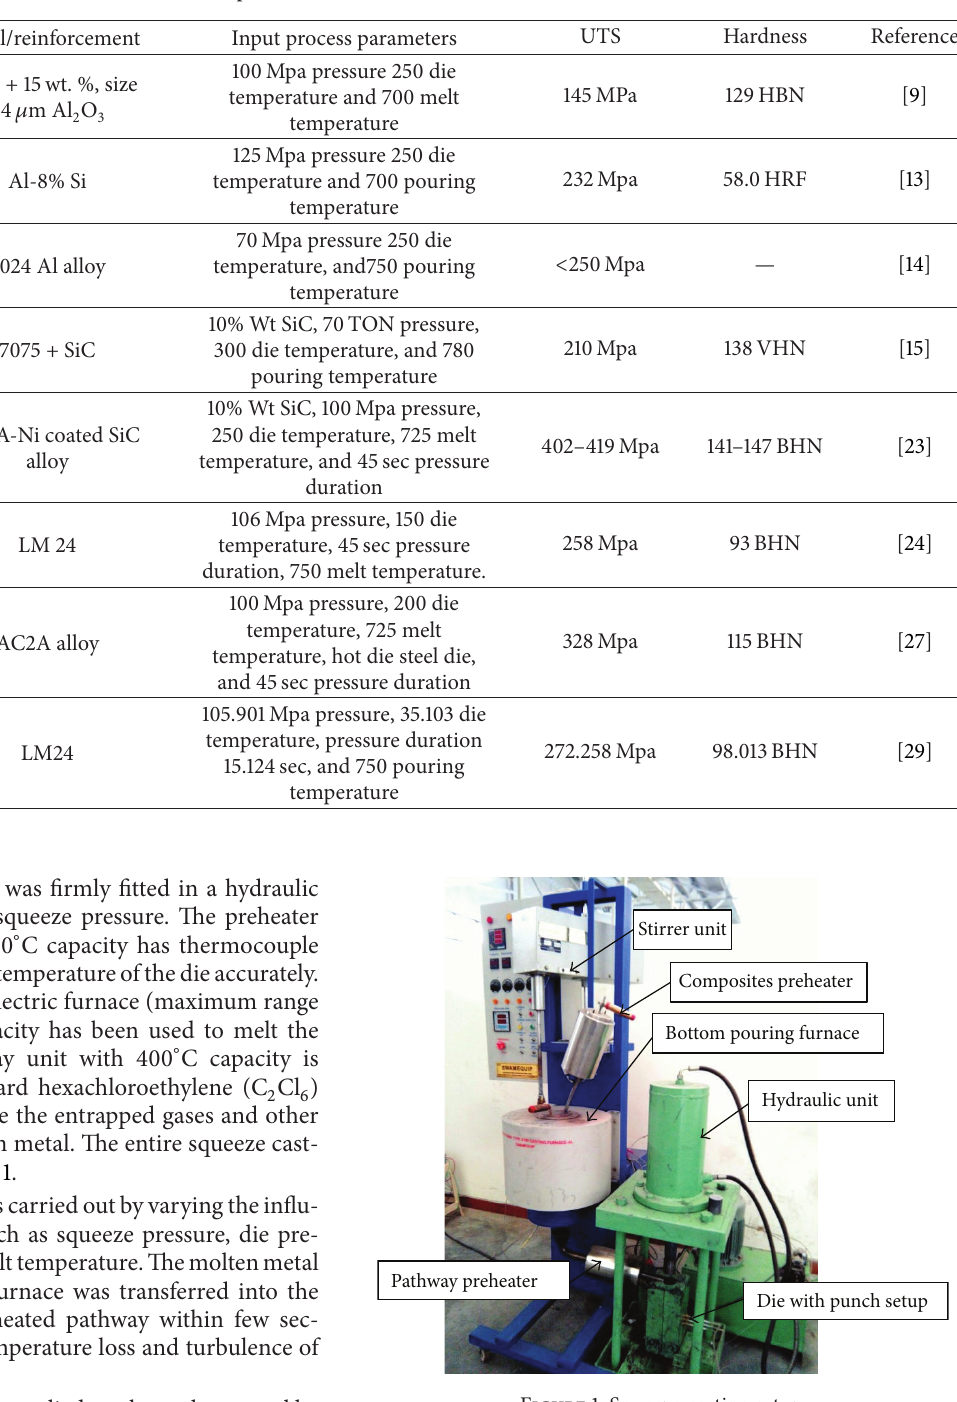
Figure 1: Squeeze casting